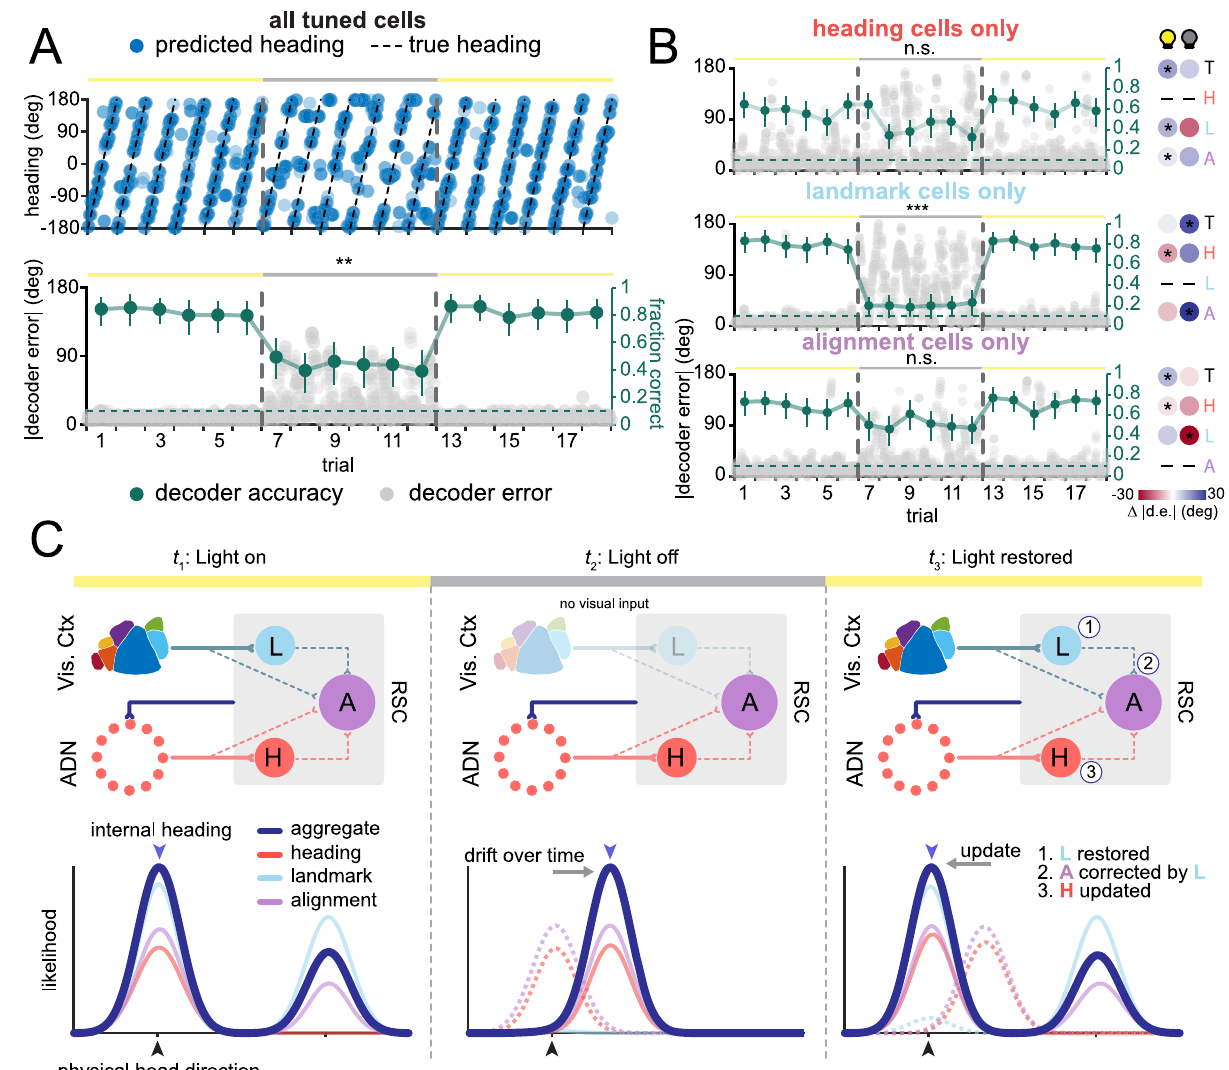
Fig. 6 | Decodinganalysis showsindependent contributionsofeach functional subclass to the overall heading representation in RSC. A Pseudopopulation decodingofneuralresponsesacrosstrials.Top:Predictedheadingplottedforeach 100ms time bin (blue dots) overlaid onactualheading (black dotted line) for each trial, transitioning from the light-on (yellow bar) to the light-off (gray bar) condi- tion. Thetransition line betweenconditionsisshown asa verticalgraydashed line. Bottom: Decoder error (gray dots) and the averagedecoderaccuracyforeach trial (green dots and line). The dashed green line denotes chance level for decoder accuracy (0.10). Decoder accuracy is plotted as mean ± s.e.m. Bootstrapped t-test (see “ Methods ” ), n =1000 bootstrapped samples. p =7.6×10 − 3 . B Top: Decoder error(graydots)anddecoderaccuracy(greendotsandline)fordecoderusingonly heading cells across conditions (left). p =0.11 Comparison of decoder error betweenheadingclasscellsandothercellclasses(T:total,H:heading,L:landmark, A: alignment) showing differences in performance across classes (right). Red shading indicates that the heading class outperforms the compared class; blue